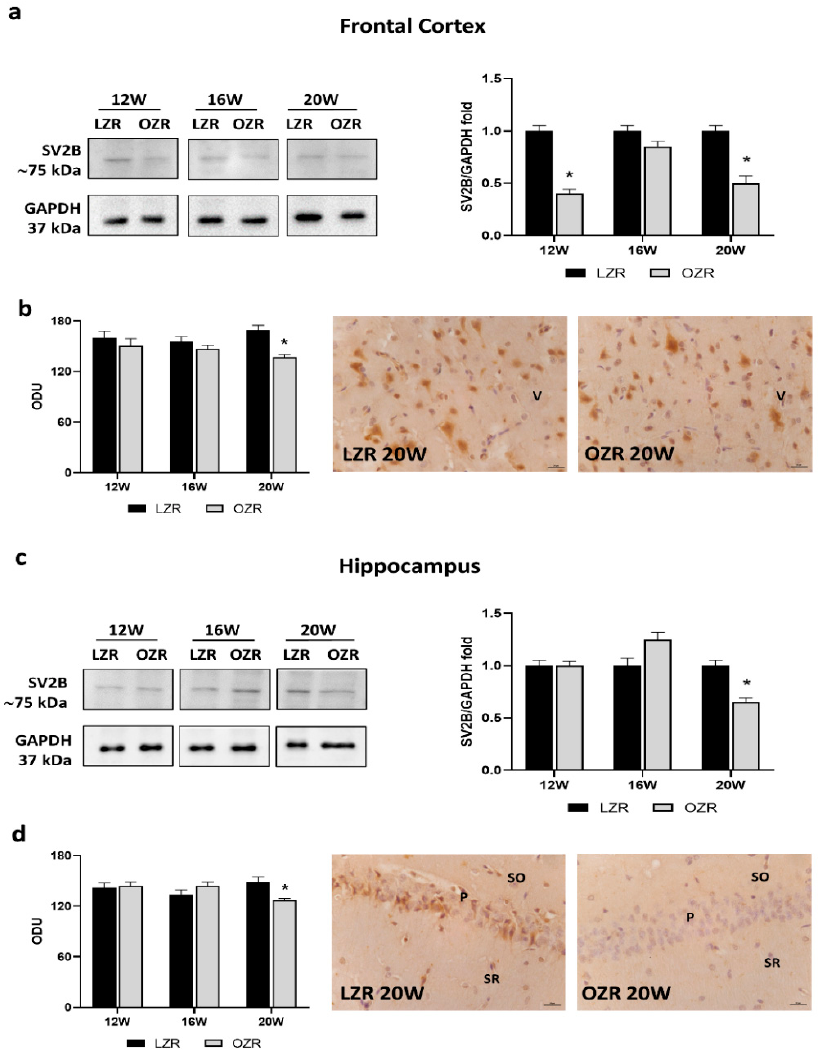
Figure 6. Immunoblotting and immunoreaction of synaptic vesicle glycoprotein 2B (SV2B). Lysates of the frontal cortex ( a ) and hippocampus ( c ) from lean Zucker rats (LZRs) and obese Zucker rats (OZRs) at the age of 12, 16, and 20 weeks were immunoblotted using specific anti-SV2B. Bar graphs indicate the densitometric analysis using LZRs as control, and GAPDH levels were used as the loading control. Blots are representative of one of three separate experiments; intensity values of SV2B immunostaining in the frontal cortex ( b ) and hippocampus ( d ) from LZRs and OZRs at the age of 12, 16, and 20 weeks measured in optical density units (ODUs). Data are mean ± S.E.M. * p < 0.05 vs. age-matched LZRs. Representative pictures of 20-week-old LZRs and OZRs in the frontal cortex ( b ) and hippocampus ( d ). V: the fifth layer of the frontal cortex. P: pyramidal neurons in the CA1 subfield of the hippocampus. SO: stratum oriens . SR: stratum radiatum . 40 × magnification. Calibration bar: 25 µ